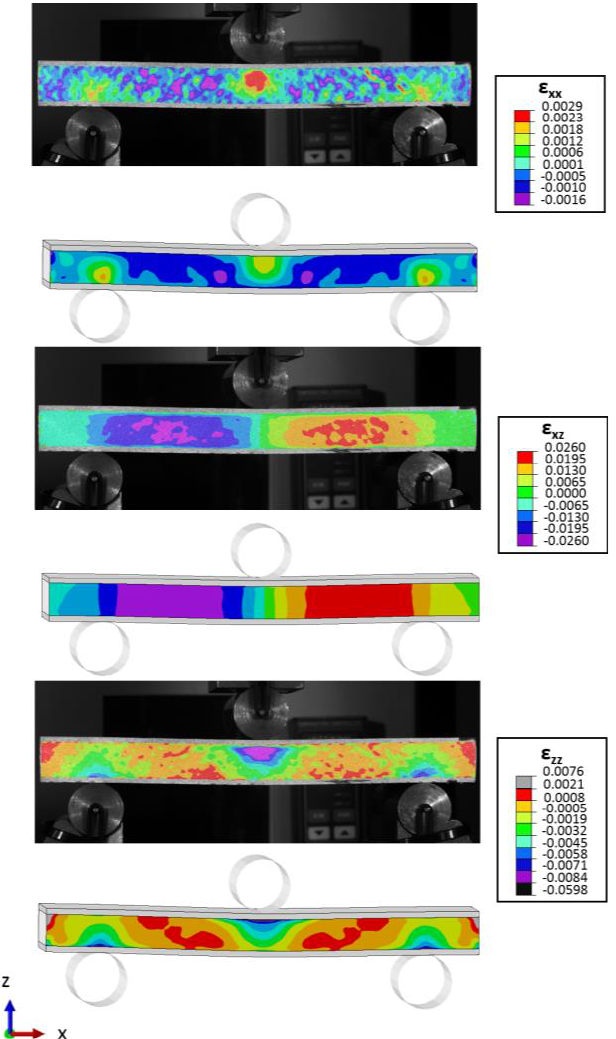
Figure 12. Comparison between DIC and FEA strain contours (applied displacement of 1.5 mm) for ‘Configuration 1′ . For each component of strain, the experimental (DIC) result is shown first.